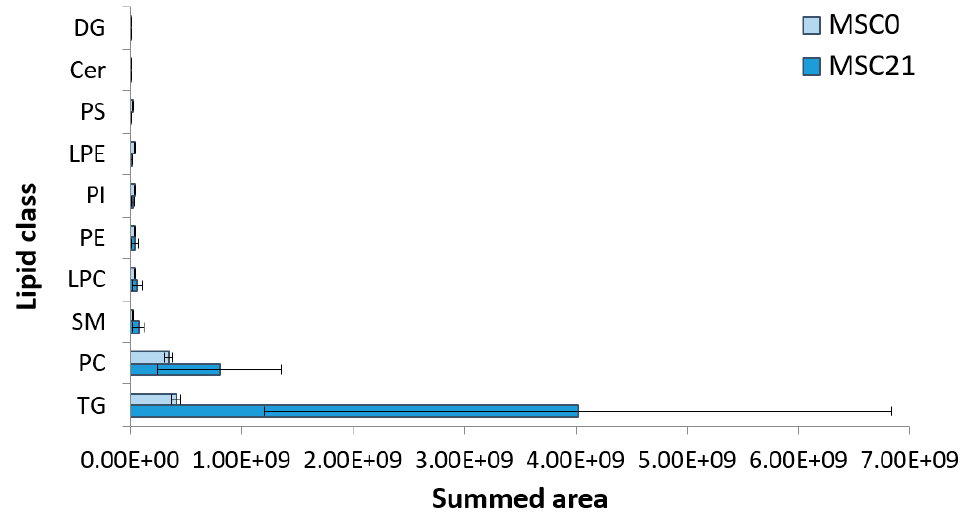
Figure Figure A4. Most abundant lipid classes in MSCs and adipocytes. Identification was performed with